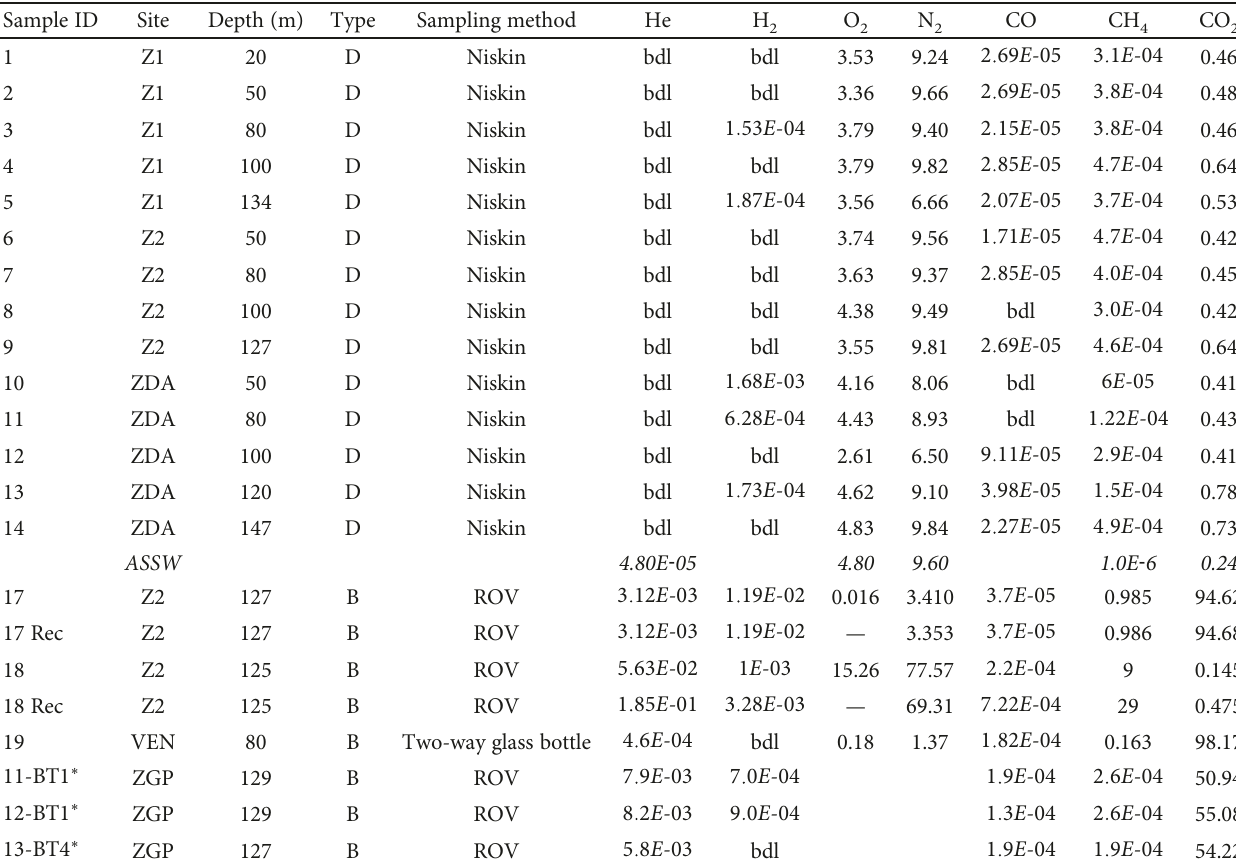
Table 3: Chemical composition of the dissolved (D) and bubbling gases